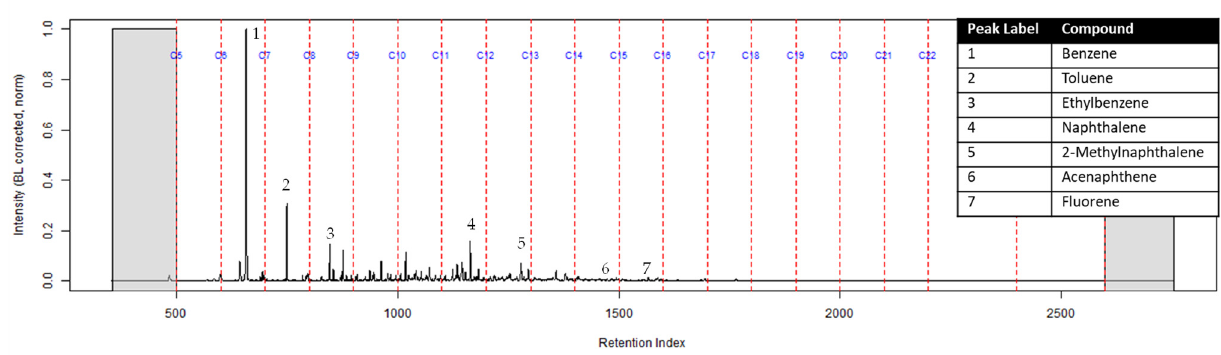
Figure 3. TIC of the CS 2 extract from the suspended activated charcoal strip from can containing 2-min MDDM burned vinyl siding and a railroad tie (maximum peak abundance 1.8 × 10 7 ).